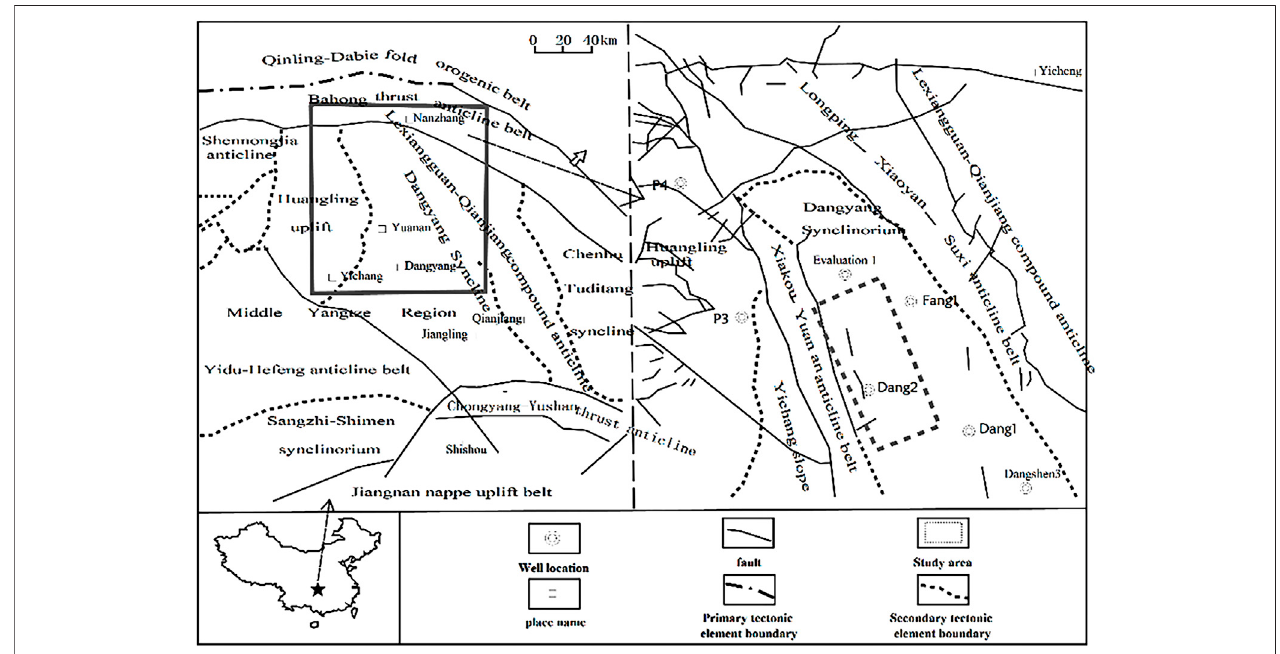
FIGURE 1 | Regional tectonic location in Jingmen area, central Hubei [Revised according to the literature (Chen et al., 2016)].